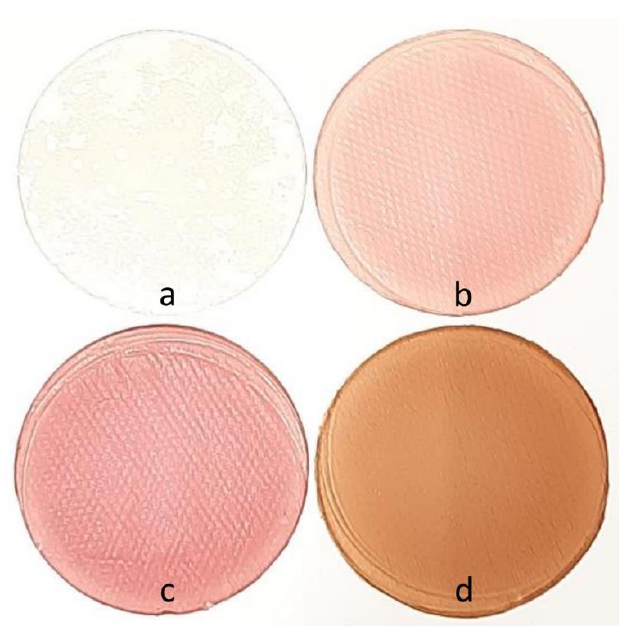
Figure 5. Developed films: ( a ) pectin (control); ( b ) raspberry; ( c ) blackberry; and ( d ) blueberry.